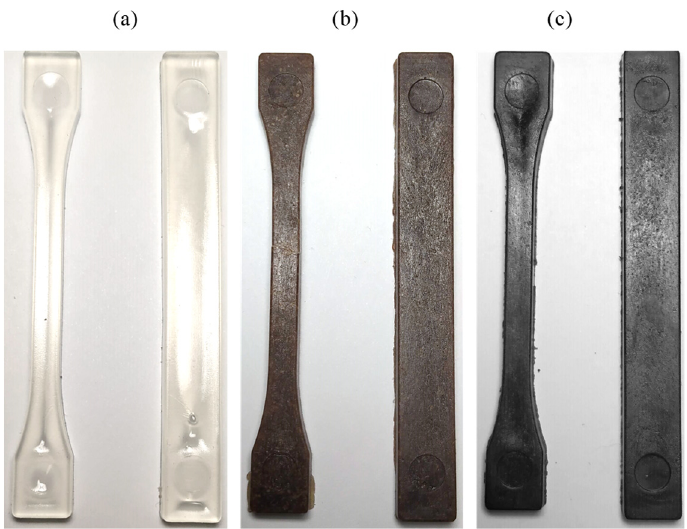
Figure 3. Visual aspect of the injection-molded pieces of: ( a ) Neat polylactide (PLA); ( b ) PLA filled with 20 wt% of coffee husk flour (CHF); ( c ) PLA filled with 20 wt% of torrefied coffee husk flour (TCHF).